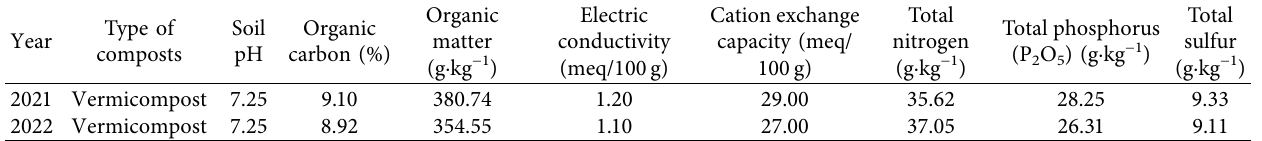
Table 1: Chemical composition of vermicompost.